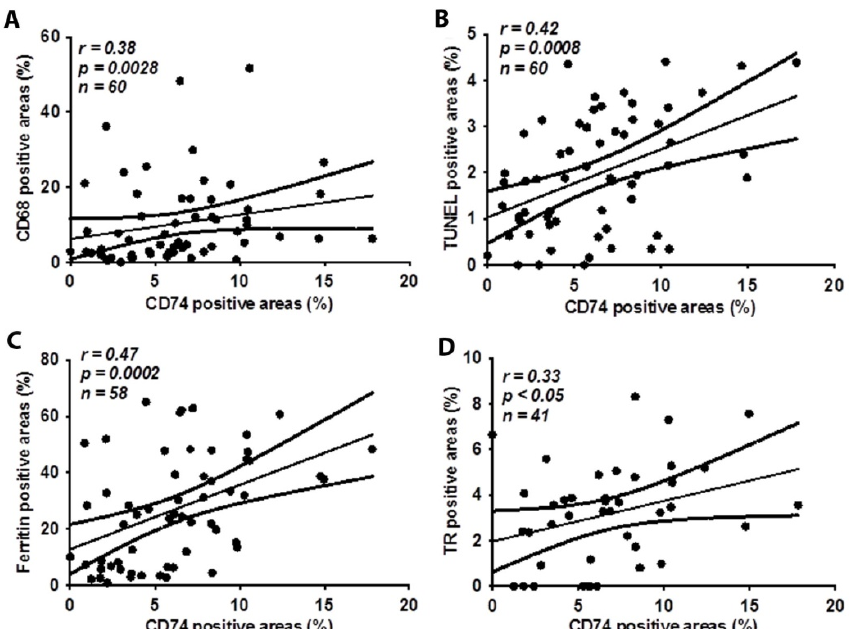
Figure 2. CD74 levels are positively correlated to CD68 positive macrophages, apoptosis, ferritin, and thrombin receptor (TR). Serial sections of carotid atherosclerotic lesions were stained with CD74, CD68, TUNEL, ferritin and TR. The correlation between CD74 and CD68 ( A ), TUNEL ( B ), ferritin ( C ), and the TR ( D ) were assessed by Spearman’s correlation coefficient test.